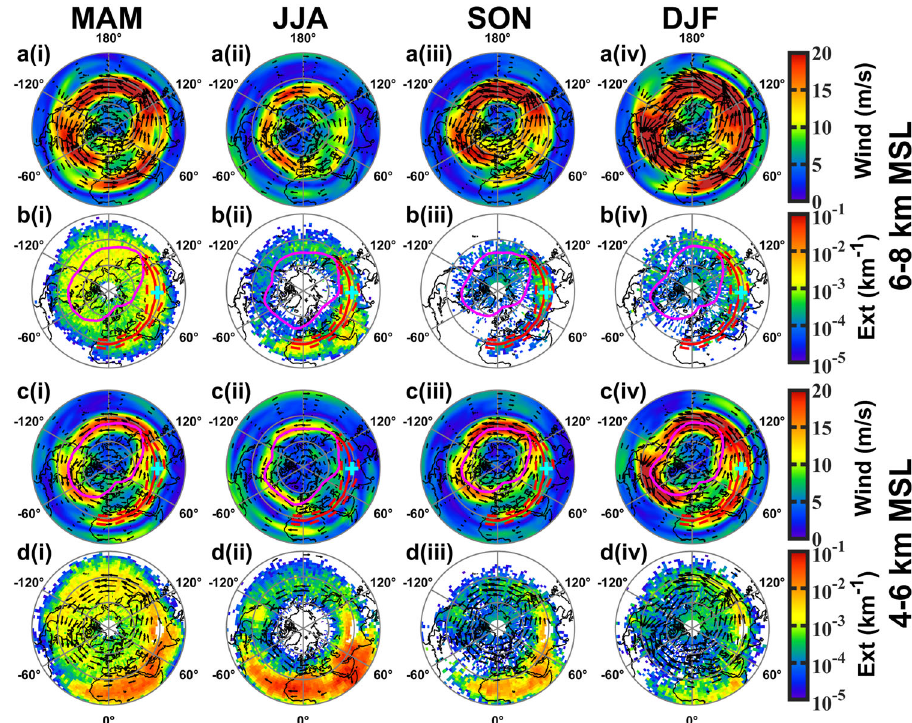
Fig. 2 Northern hemisphere seasonal horizontal wind and dust extinction (ext) variations between 4 – 6 km and 6 – 8 km above mean sea level (MSL). For each map, the three circles from outside to inside represent 0°, 30°N, and 60°N latitude. a(i) – a(iv) Seasonal mean velocity fi eld overlaid by wind vectors between 6 and 8km MSL. b(i) – b(iv) Seasonal dust extinction between 6 and 8km MSL. The red and purple lines are dust transport tracks (same as in Fig. 1). c(i) – c(iv) Same as a(i) to a(iv) but for between 4 and 6km MSL. d(i) – d(iv) Seasonal dust extinction overlaid by wind vectors with wind speed larger than 7m/s between 4 and 6km MSL. From left to right are four seasons March – April – May (MAM), June – July – August (JJA), September – October – November (SON) and December – January – February (DJF), respectively. The cyan plus sign in rows b and c marks the location of the Tibetan Plateau (TP). Dust extinction is shown for those pixels with dust occurrence larger than